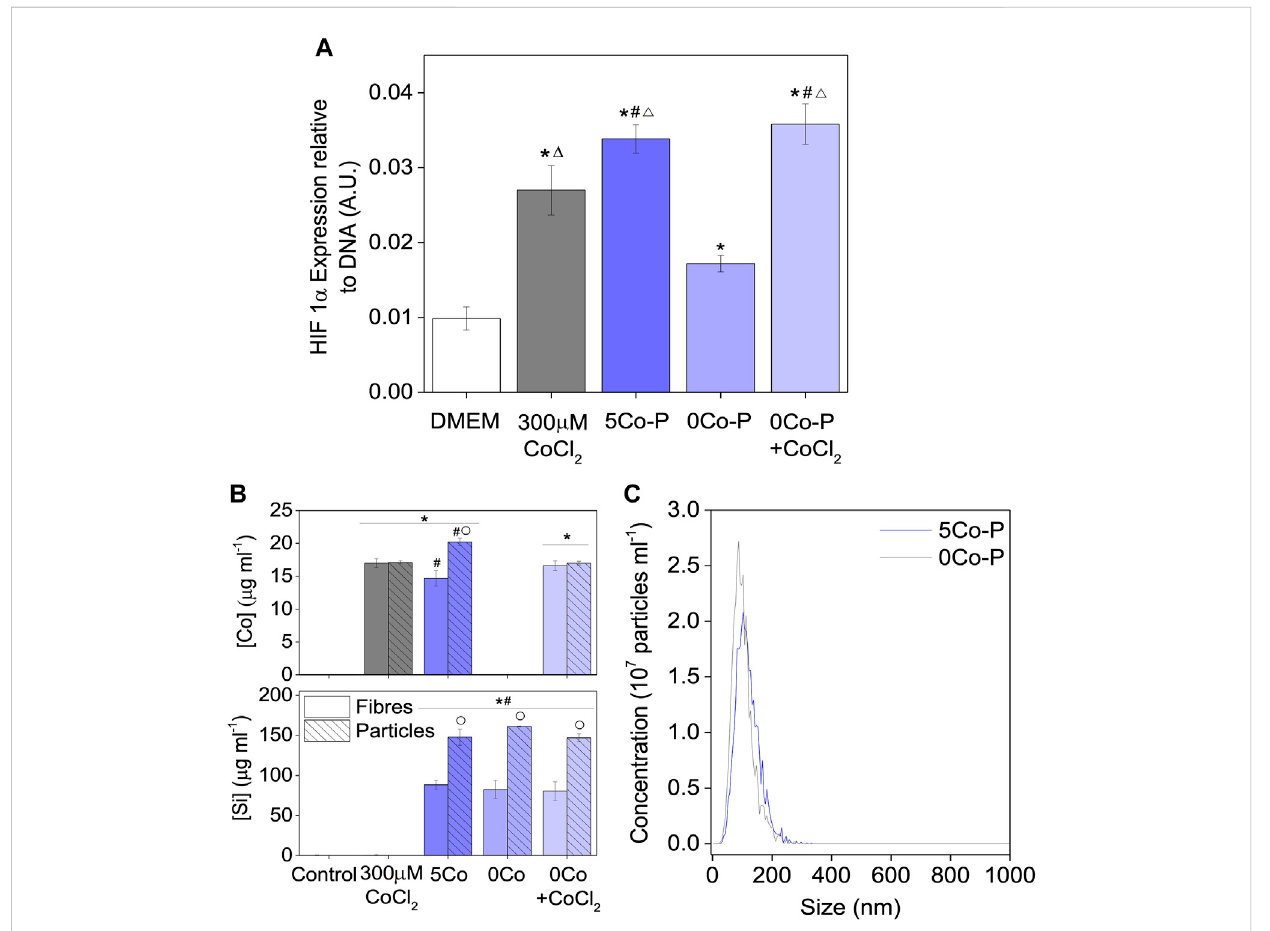
FIGURE 7 Increase in HIF-1 α measured when keratinocytes are exposed to conditioned media from glass powder for 4 h. Data are represented as mean ± standarddeviationwithN=3 (A) .CoandSiconcentrationsinDMEMfortheglass fi breandglassparticleconditionedmediapreparedataratioof6.67 mg ml − 1 ;dataarerepresentedasmean±standarddeviationwithN=7fortheFibreconditionsandN=3fortheParticleconditions (B) andsizedistributionof nanoparticles measured, by Nanoparticle Tracking Analysis, in 5Co and 0Co glass particle conditioned media (5Co-P and 0Co-P) (C) . Statistical signi fi cance was determined with a one way ANOVA, with a Tukey means comparison test with * p < 0.05 compared to DMEM, # p < 0.05 compared to 300 μ M CoCl 2 , Δ p < 0.05 comparedto 0Co-P in (A) and * p < 0.05 compared to DMEM in both the fi bre and particle experiment, # p < 0.05 comparedto 300 µM CoCl 2 controls in both the fi bre and particles experiment, ○ p < 0.05 compared to the glass particle conditioned media for the same condition in (B)